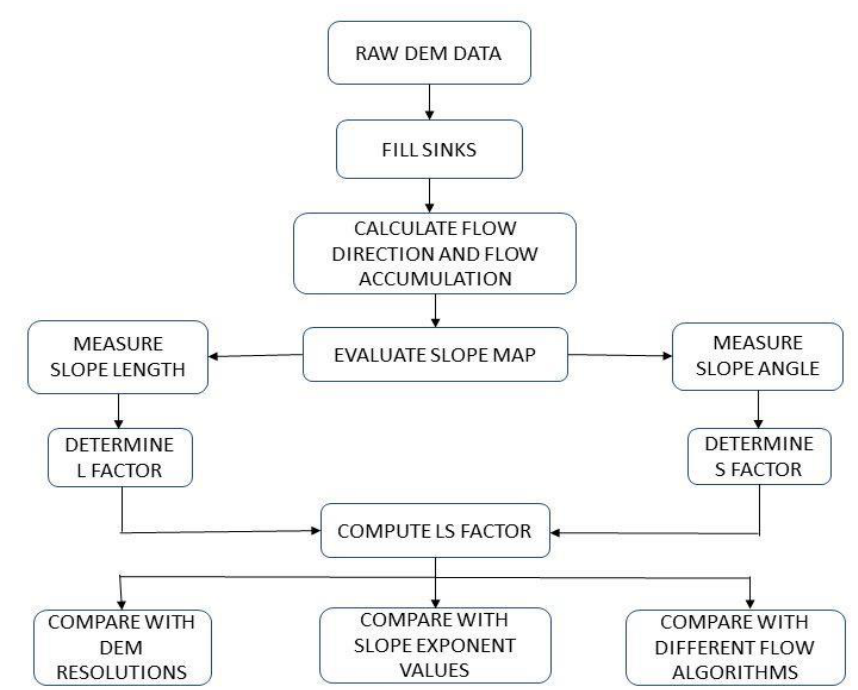
Figure 3: Methodology flowchart of the process